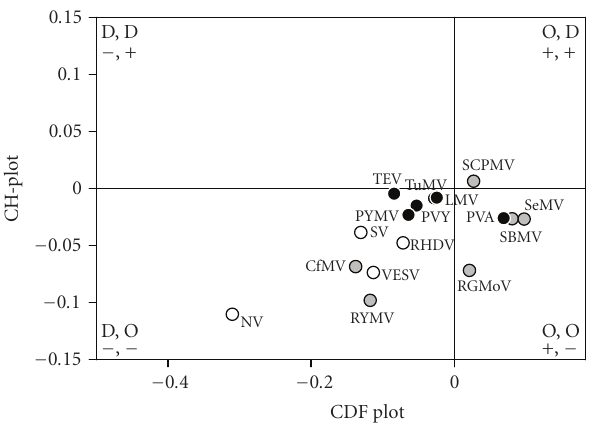
Figure 3: CH-CDF analysis of the genome-linked proteins VPgs from various viruses . Comparison of the results of PONDR CDF and CH- plot analyses for whole protein order-disorder via distributions of VPgs within the CH-CDF phase space. The protein analyzed by this approach are VPgs from Sobemovirus (Rice yellow mottle viru s (RYMV), Cocksfoot mottle virus (CoMV), Ryegrass mottle virus (RGMoV), Southern bean mosaic virus (SBMV), Southern cowpea mosaic virus (SCPMV), Sesbania mottle virus (SeMV)), Potyvirus (Lettuce mosaic virus (LMV), Potato virus Y (PVY), Potato virus A (PVA), Tobacco etch virus (TEV), Turnip mosaic virus (TuMV), Bean yellow mosaic virus (BYMV)), and Caliciviridae (Rabbit hemorrhabic disease virus (RHDV), Vesicular exanthema of swine virus (VESV), Man Sapporo virus Manchester virus (SV), and Norwalk virus